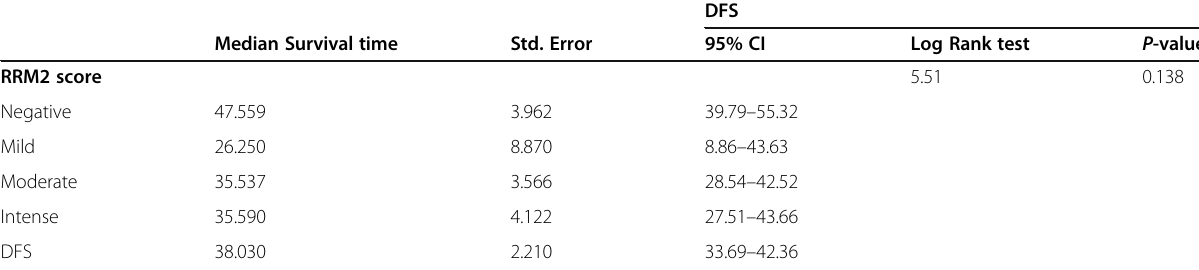
Table 4 Kaplan-Meier DFS for RRM2 score in ER positive